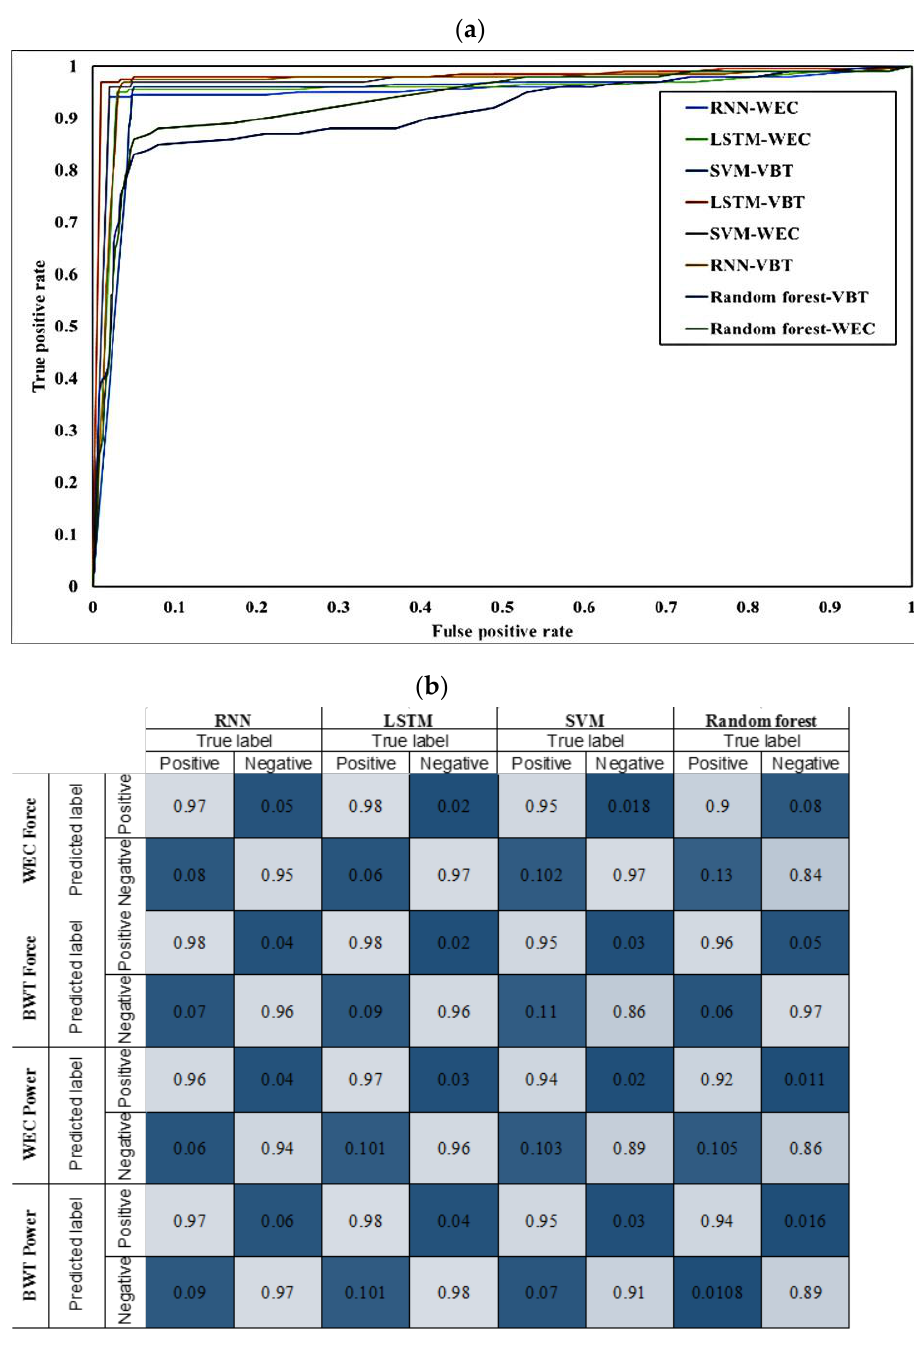
Figure 5. ROC curve ( a ) and confusion matrix ( b ) of different utilized algorithms in predicting VBT